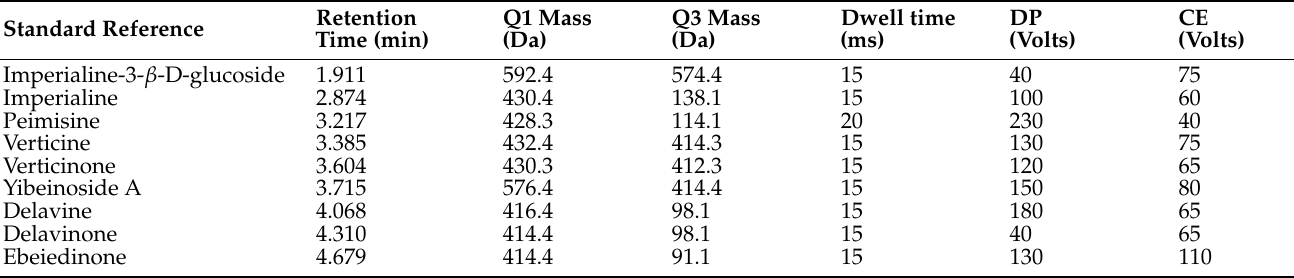
Table 2. MS detection parameters of nine